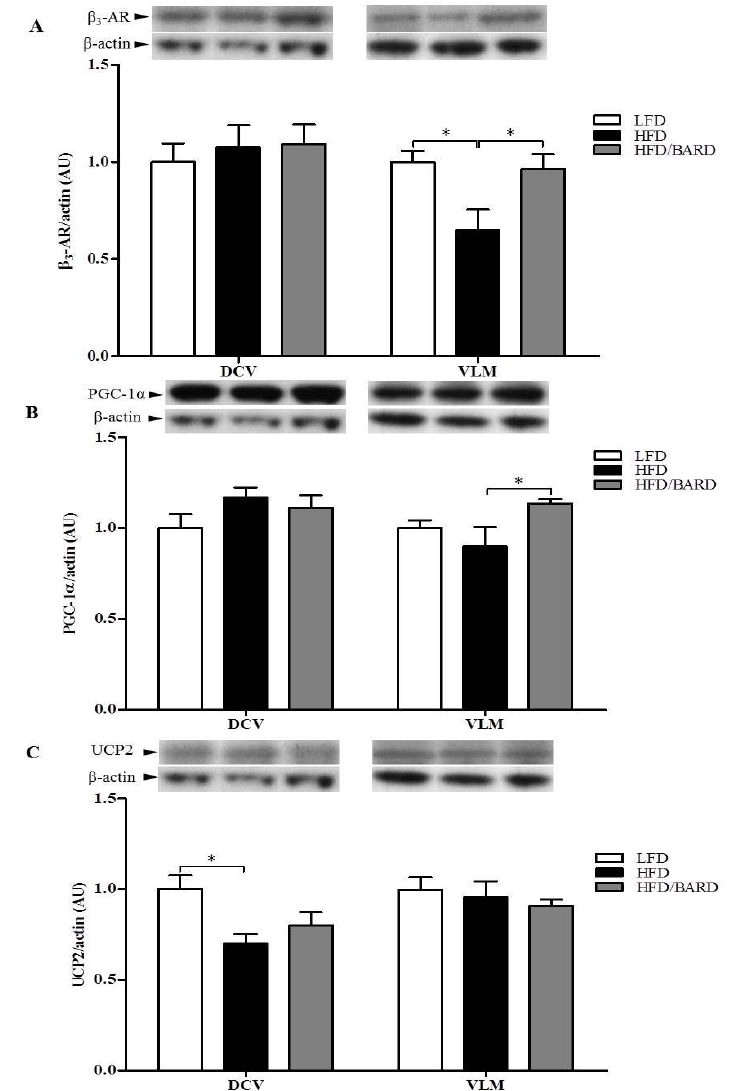
Figure 6. Effect of bardoxolone methyl (BARD) on the expression of energy expenditure proteins in the brainstem of mice fed: low-fat diet (LFD), high-fat diet (HFD), and high-fat diet supplemented with BARD (HFD/BARD). ( A ) β 3 -AR protein and representative blots ( B ) PGC1- α protein and representative blots; ( C ) UCP2 protein and representative blots. All data are expressed as mean ± SEM, * p < 0.05, ** p < 0.01. β 3 -AR: beta 3-adrenergic receptor; PGC1- α : peroxisome proliferator-activated receptor gamma coactivator 1-alpha; UCP2: uncoupling protein 2; DVC: dorsal vagal complex; VLM: ventrolateral medulla; AU: arbitrary